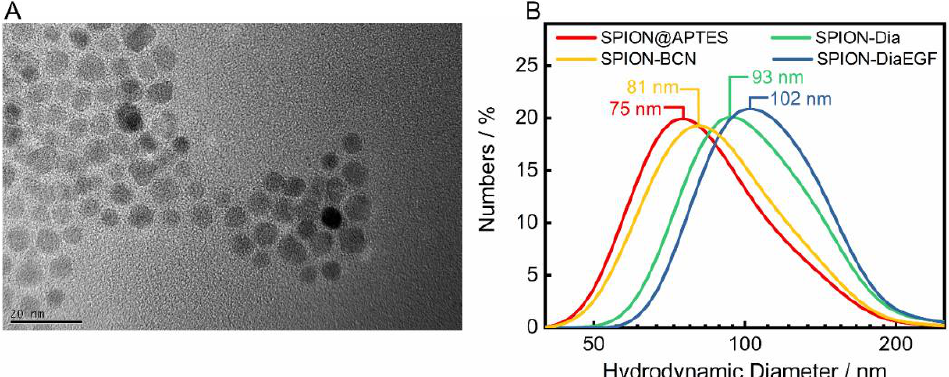
Figure 2. ( A ) Total amount of conjugated NHS-PEG 12 -N 3 linker on Dianthin (Dia) and DianthinEGF (DiaEGF) and ( B ) the corresponding enzymatic activity in dependence of the initially used molar ratio of linker to the respective ribosome-inactivating protein (RIP; Dia or DiaEGF). Activity results are shown relative to the activity of unconjugated Dia, which was set to 100%.